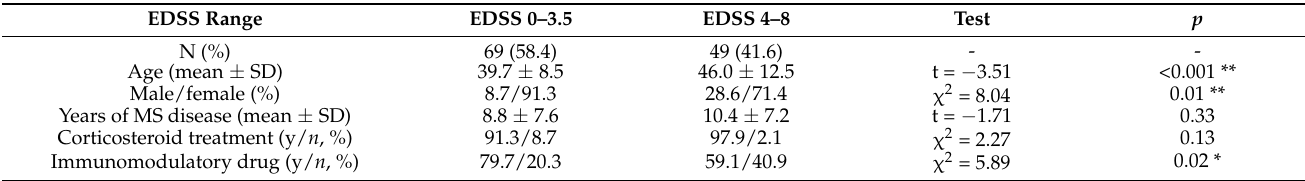
Table 4. Differences regarding disability status (EDSS)